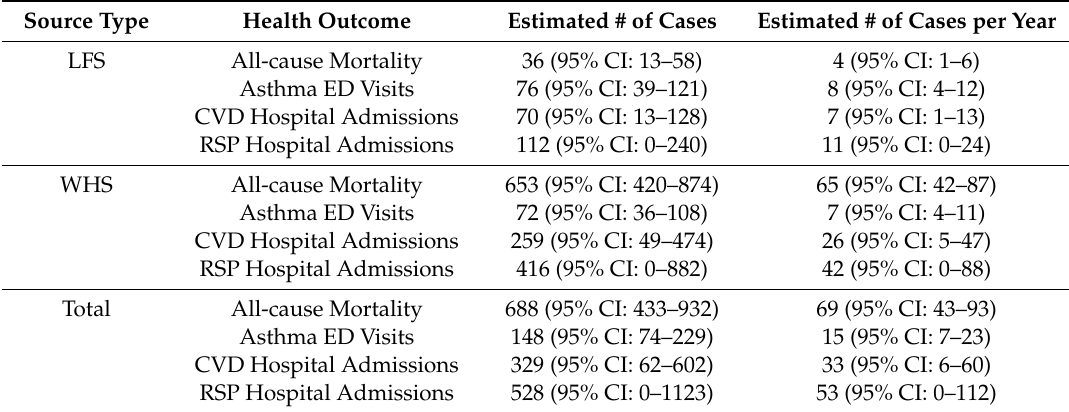
Table 3. Estimated number of cases per health outcome and source type.